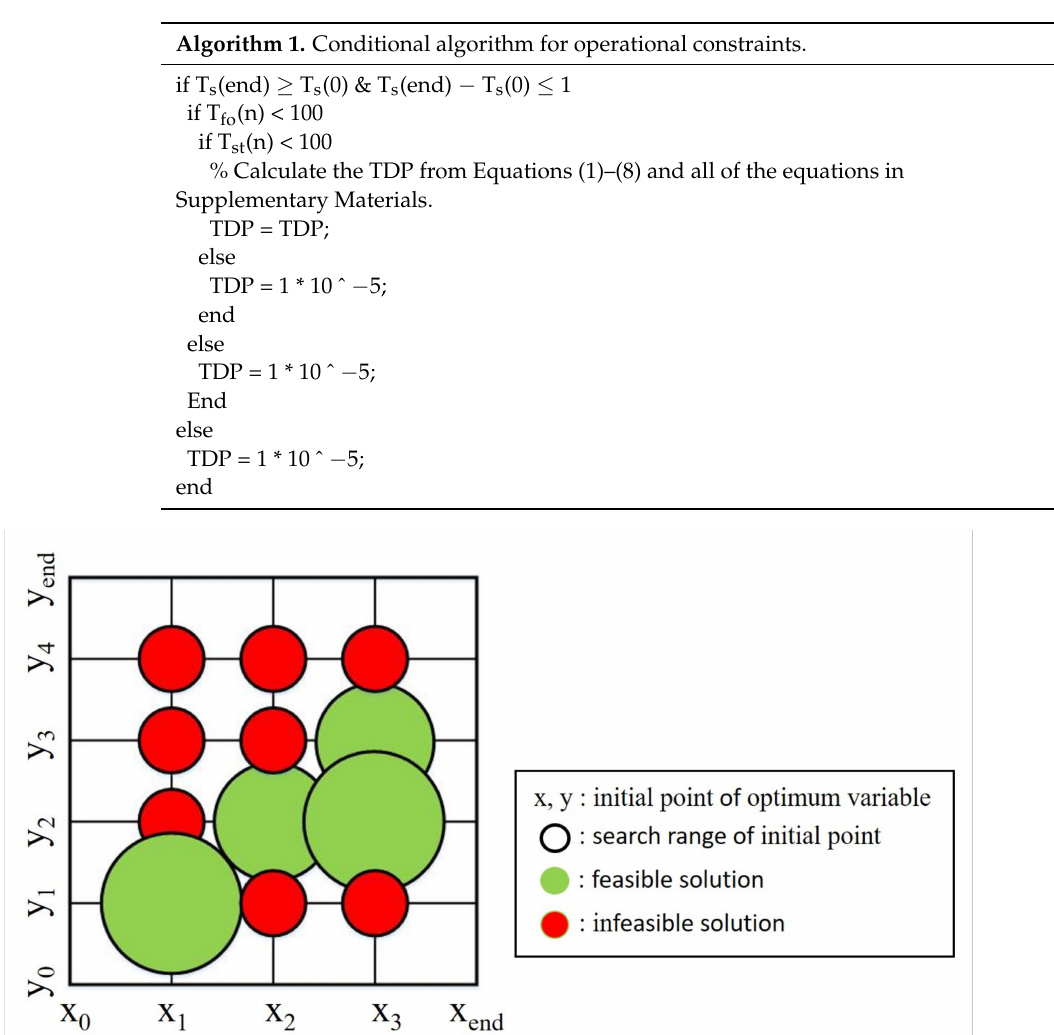
Figure 7. Grid initial values strategy for ensuring solution globality (full-range scan